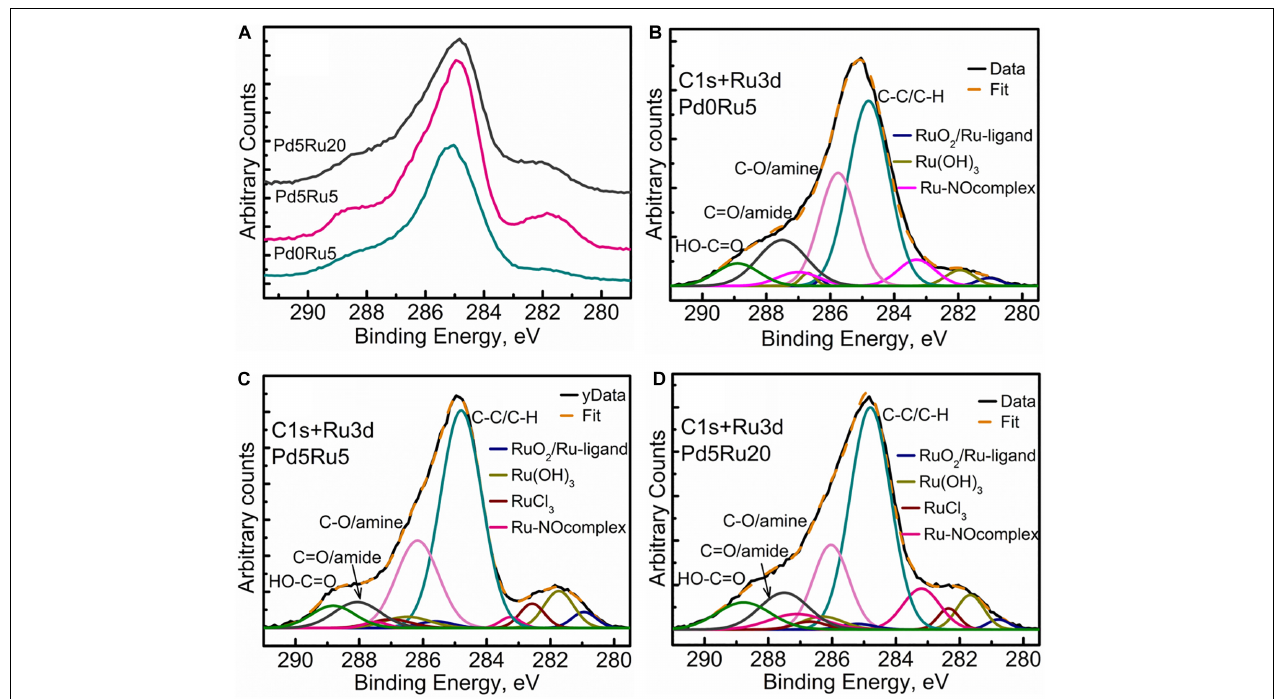
FIGURE 7 | Carbon and Ruthenium XPS spectra showing (A) comparison of high resolution C 1s+Ru 3d region for all three samples, (B) C 1s+Ru 3d peak fitting for low Ru only sample, (C) C 1s+Ru 3d peak fitting for low Pd and low Ru loading sample, (D) C 1s+Ru 3d peak fitting for low Pd and high Ru loading sample.